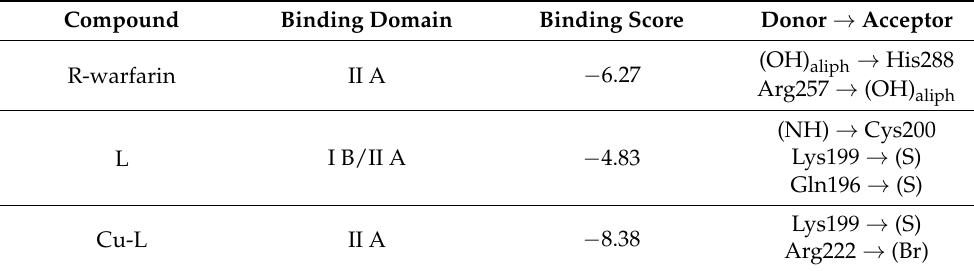
Figure 4. Different interaction domains of L ( left ) and Cu-L ( right ) with HSA. Table 2. Binding scores and interactions of L and Cu-L against HSA as proposed by